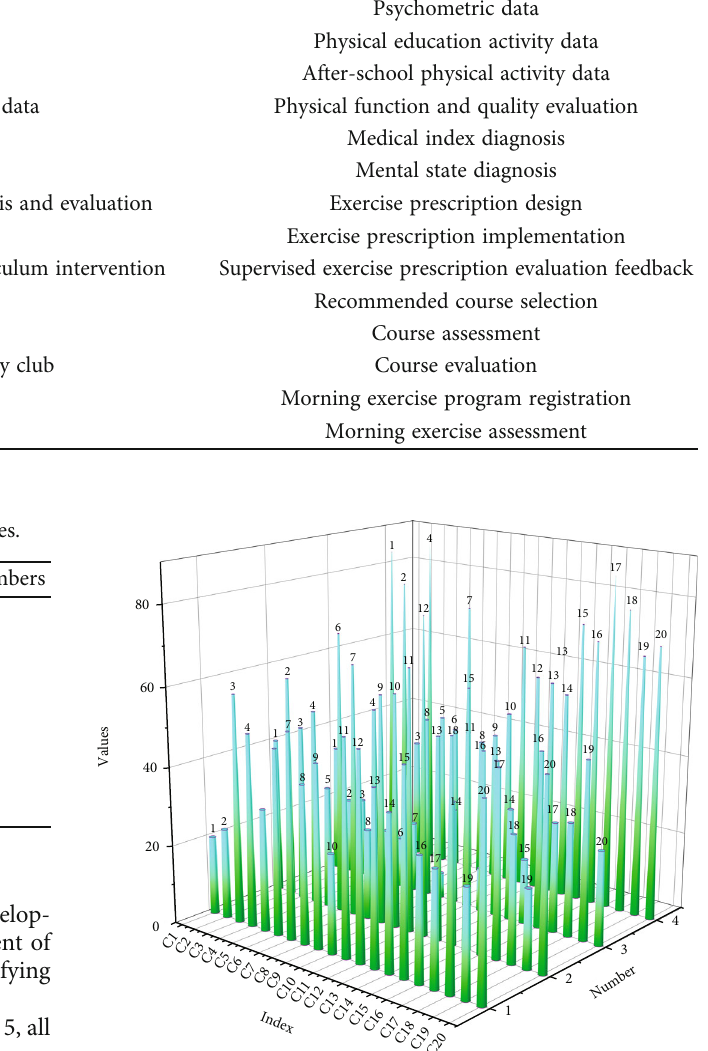
Figure 4: Evaluation